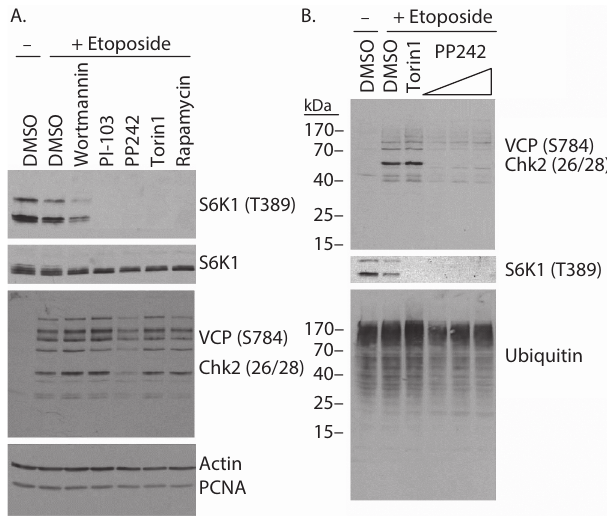
Figure 4. PP242 inhibits etoposide-induced phosphorylation of Ser/Thr-Gln motifs. A ) Western blot analysis of lysates from HeLa cells pretreated with the indicated inhibitors prior to etoposide treatment reveals that PP242 reduces the appearance of multiple phospho-SQ/TQ epitopes recognized by the broadly reactive phospho-VCP/Chk2 antibody. B ) Varying concentrations of PP242 from 0.34–1.25 µM block etoposide-induced phosphorylation of proteins recognized by the phospho-SQ/TQ